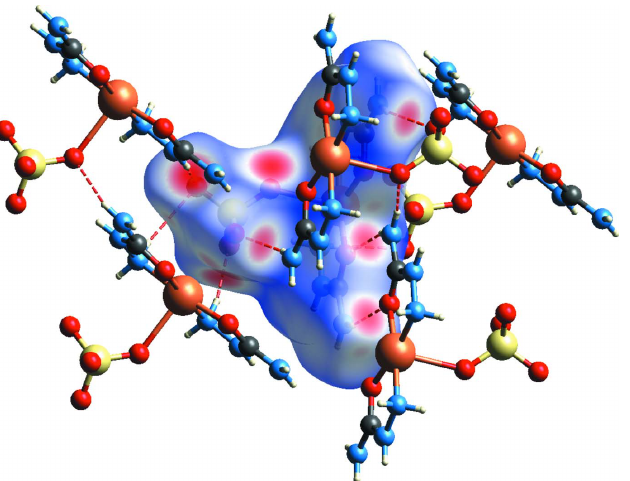
Figure 4 View of the Hirshfeld surface plotted over d norm .